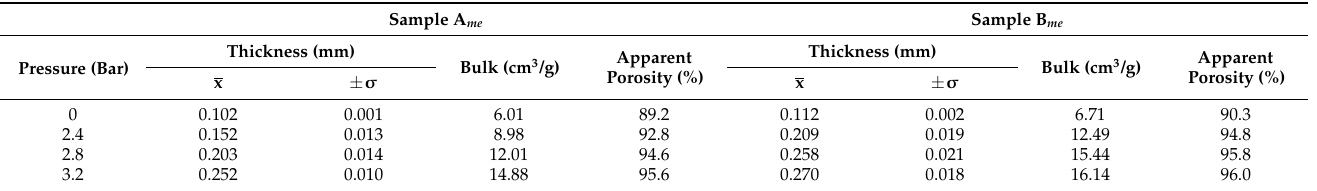
Table 2. Thickness, bulk, and apparent porosity results for the base tissue paper samples A and B at different pressures with micro embossing.